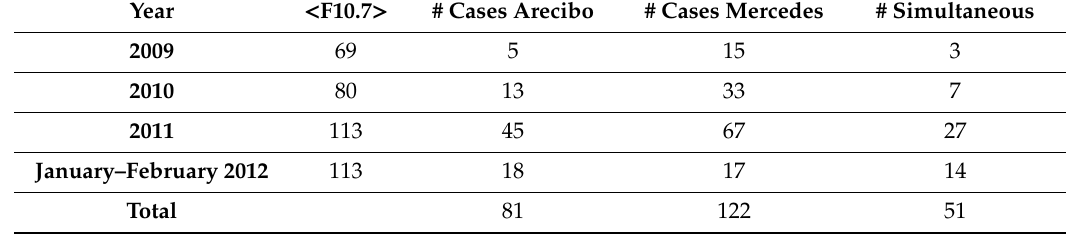
Table 1. Summary of the number of ESF-related airglow depletions observed at Mercedes and Arecibo.